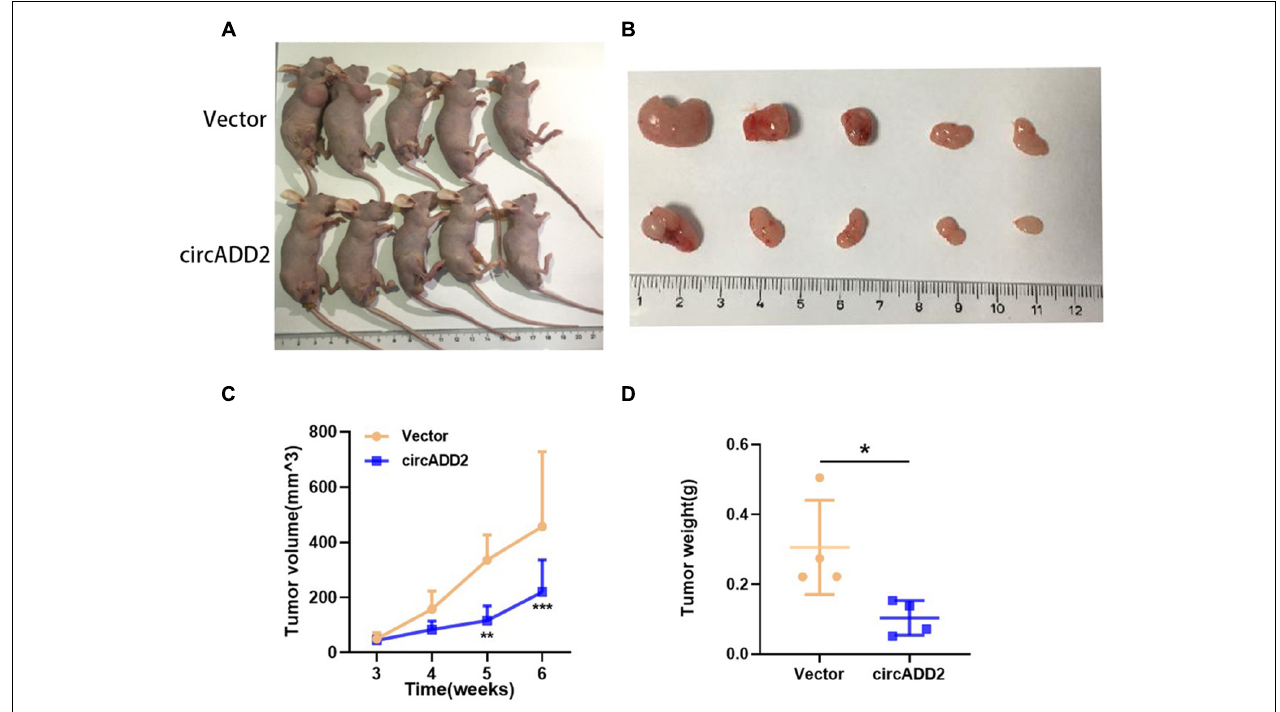
FIGURE 3 | Over-expressed circADD2 Jurkat cells were injected into nude mice to detect the effect of circADD2 ( n = 5) in vivo . (A) Jurkat cells stably transfected with circADD2 or control vector were injected into nude mice with established subcutaneous xenograft tumors. (B) Representative pictures of xenograft tumor formation in nude mice (top: control group; bottom: treated group). (C,D) Compared with the vector group, circADD2-treated nude mice exhibited significantly smaller tumor volume and significantly lighter tumor weight after cell injection for 5–6 weeks. Data were showed as mean ± SD and analyzed by unpaired t -test, * P < 0.05, ** P < 0.01, *** P <